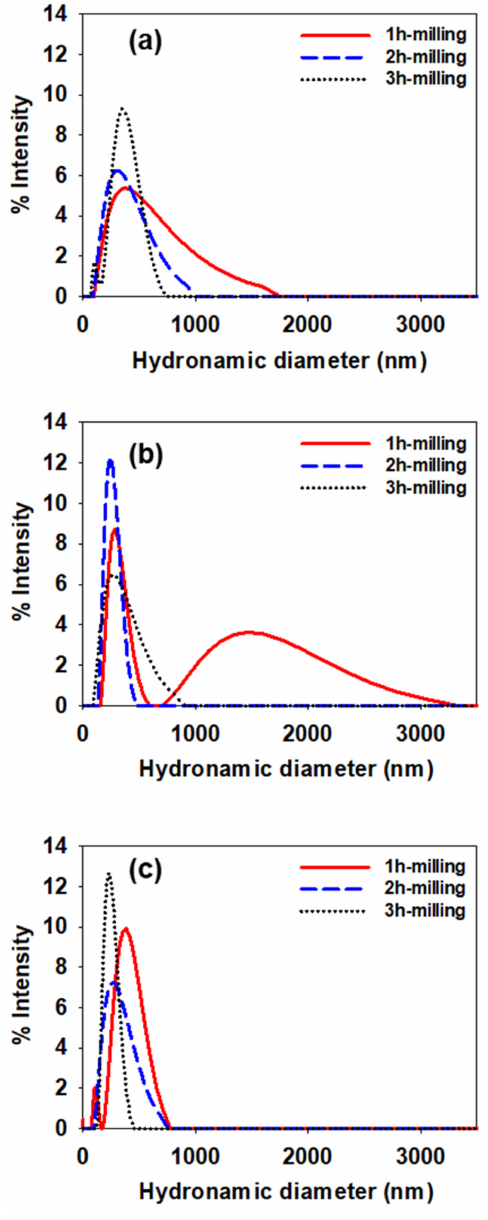
Figure 9. Particle size distributions obtained by DLS for the CB dispersions prepared using SMA-1000